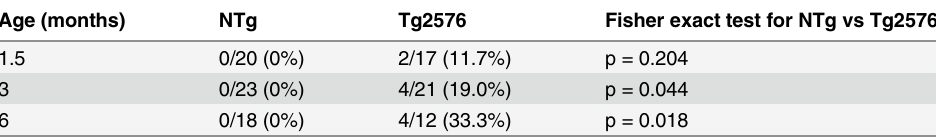
Data represent the number of animals with NPY ectopic expression in mossy fi bers compared to the total number of animals in each group. Note that only Tg2576 mice present aberrant NPY